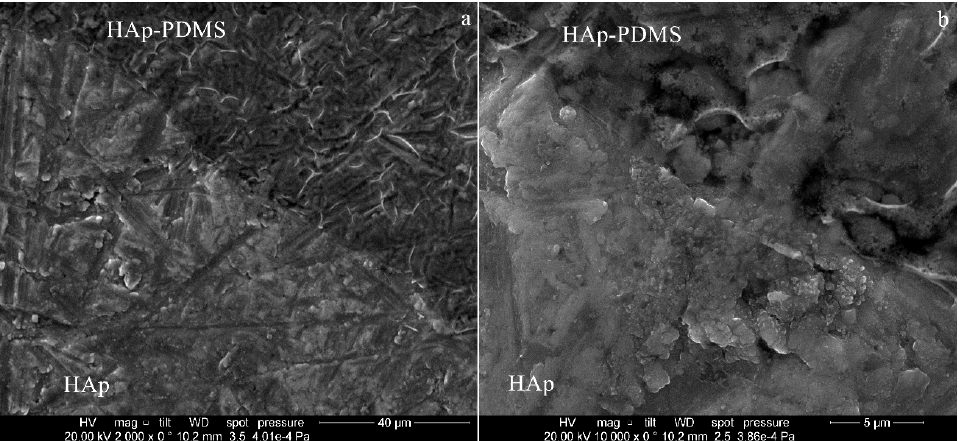
Figure 5. SEM images of the interface zone between HAp-PDMS (darker zone) and HAp (lighter zone) for different magnification: ( a ) ×2000; ( b ) ×10,000.